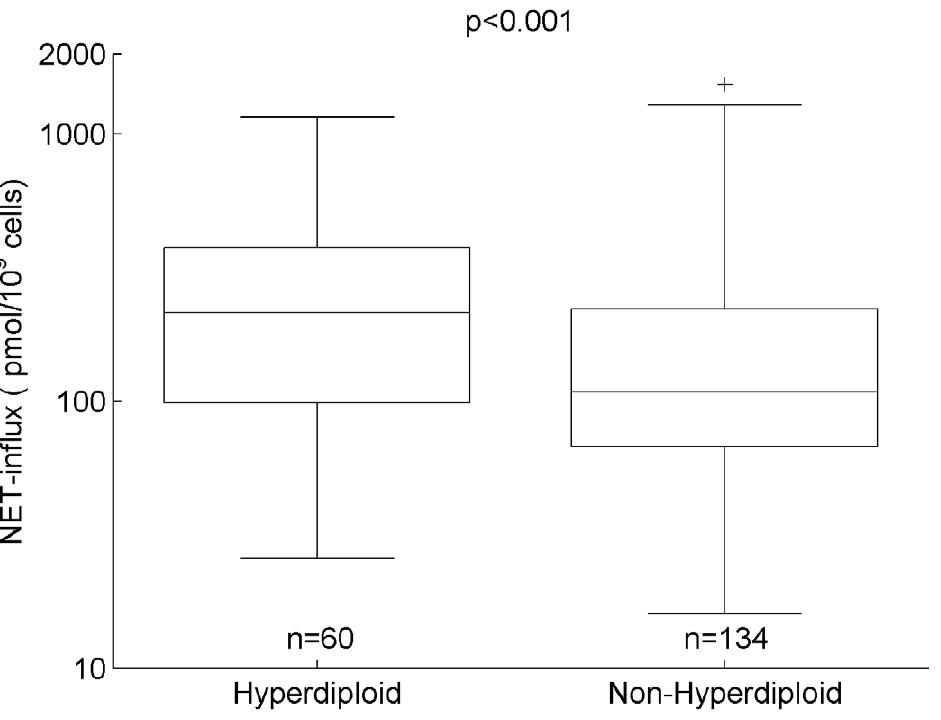
Figure 2. MTX net influx vs ALL ploidy. NET-influx (model parameter describing the net influx of MTX) vs ALL ploidy (hyperdiploid vs non- hyperdiploid). Median, quartiles, non-outliers range (defined as 1.5 times the interquartile range), and outliers (plus-marks) are depicted for B-lineage ALL.